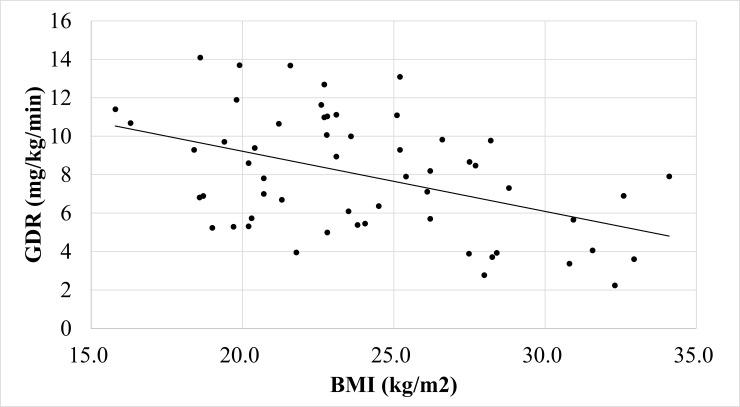
The correlation between BMI and GDR in the all participants in the clamp study.